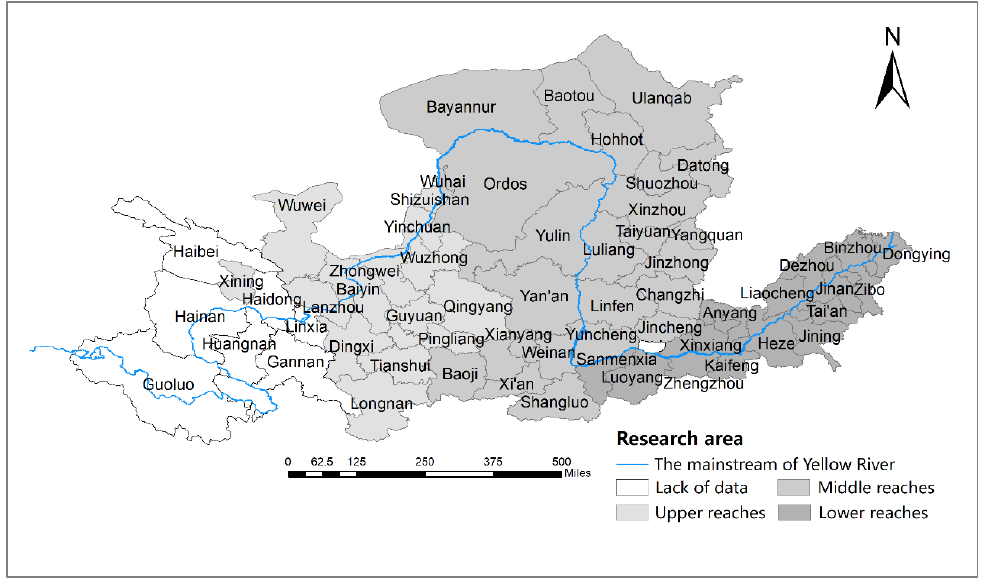
Figure 2. The research area.